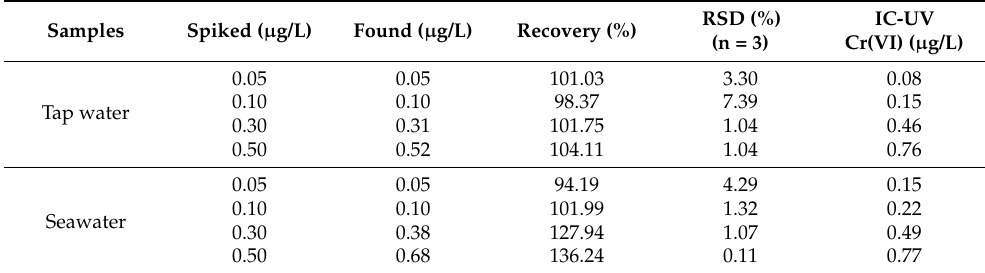
Table 2. Quantification of Cr(VI) in real water samples using as-synthesized N,Zn-CDs sensor or